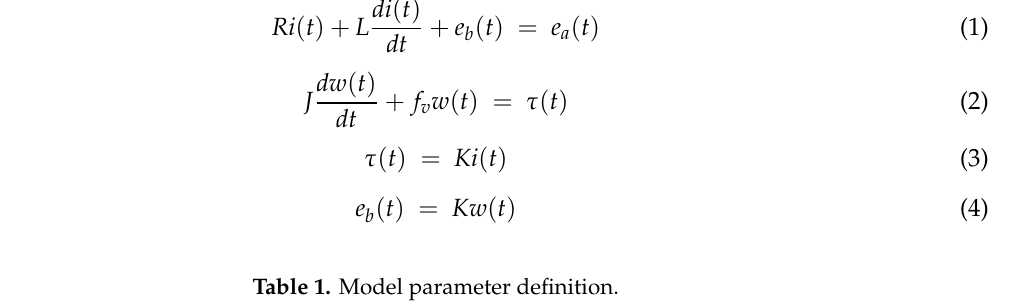
Table 1. Model parameter definition.